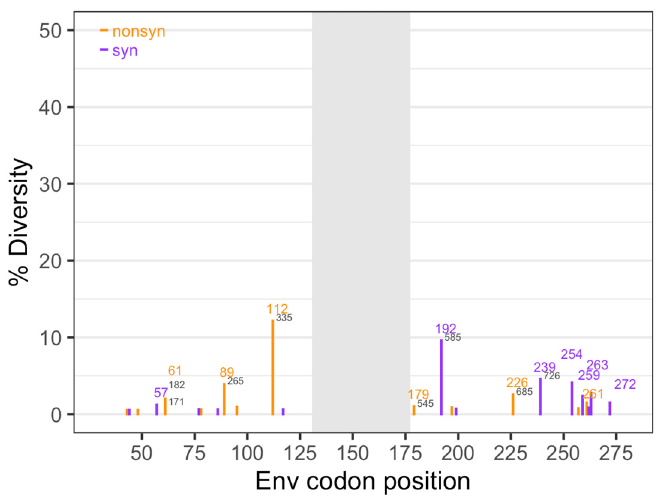
Figure 2. Diversity of the SIV challenge stock. Diversity was determined separately for nonsynony- mous (orange) and synonymous (purple) changes at each nucleotide position, based on the challenge stock consensus sequence. Numbers in colors represent the amino acid position based on SIV mac239 , and numbers in gray represent the nucleotide position based on SIV mac251 . Gray shading indicates the region missing in some of the sequences. Table 1. Comparison of diversity of the SIV challenge stocks used in this study (SIV/Mtb) and in the Ita et al. [19] study.